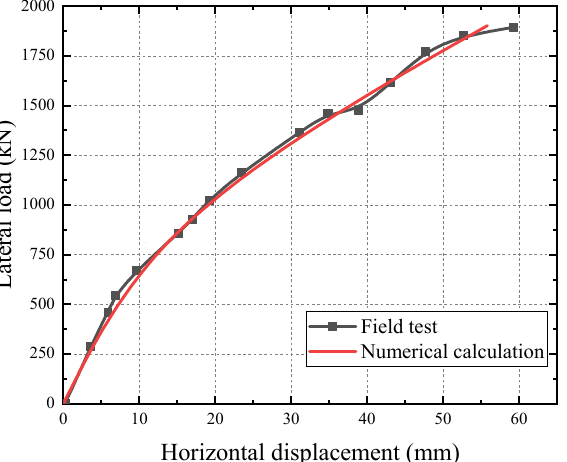
Figure 9. Comparison of the lateral load–displacement curve at the pile head from the field tests and from the numerical simulation.